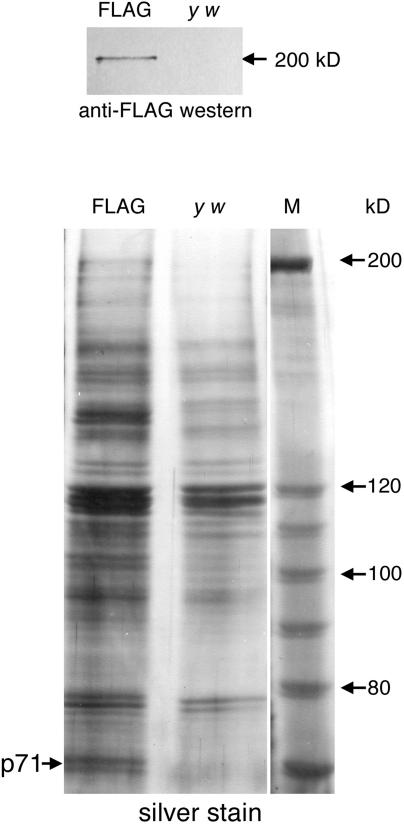
A 71-kDa Protein Co-Purifies with FLAG-Nipped-B by Anti-FLAG Affinity ChromatographyNuclear extracts of
y w; P[
Chip-FLAG-Nipped-B, w+] (FLAG) embryos and
y w control embryos were bound to anti-FLAG beads, washed, and eluted with FLAG peptide as described in the text. FLAG-Nipped-B fusion protein was detected in the
y w; P[
Chip-FLAG-Nipped-B, w+] eluate, but not in the
y w eluate, by anti-FLAG Western blot (top panel). Other eluted proteins were detected by silver stain (bottom panel). A 71-kDa protein specific to the FLAG-Nipped-B eluate was identified by mass spectrometry as the product of the
Drosophila CG4203 gene. It is closely related to the human MAU-2 protein. Higher molecular weight bands specific to the FLAG-Nipped-B extract contain multiple proteins whose identities could not be established unambiguously. In the bottom panel, the p71 protein and several other proteins, including the markers, became doublets when the gel was dried for photography. All appeared as single bands before drying.